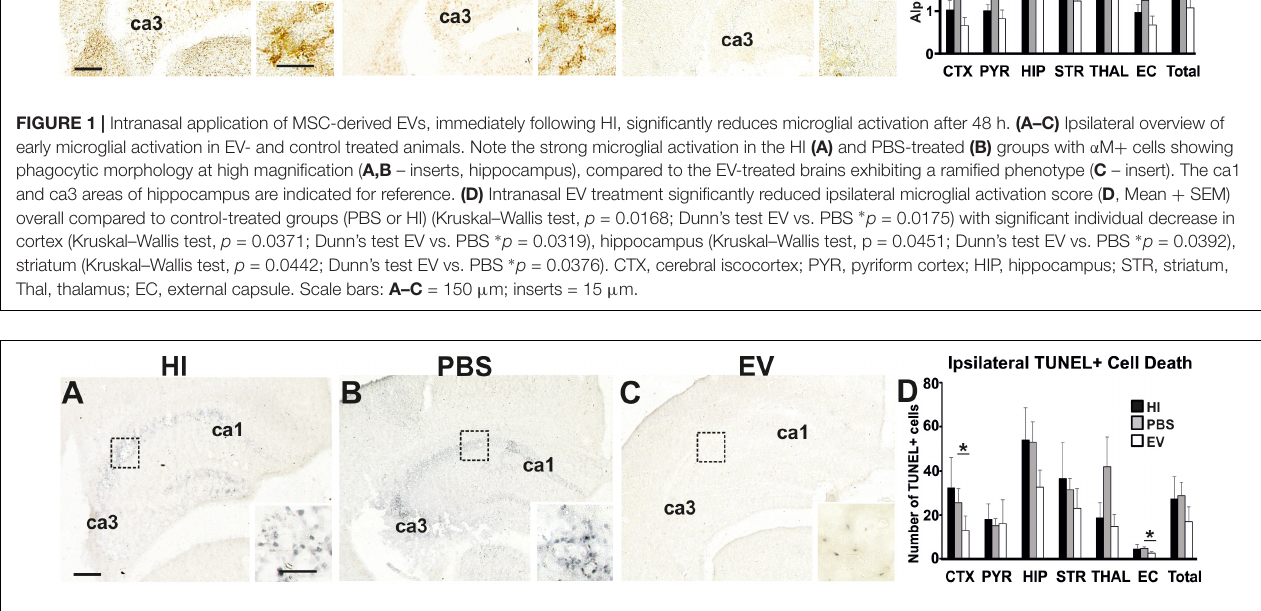
FIGURE 2 | Intranasal application of MSC-derived EVs, immediately following HI, significantly reduces TUNEL + cell death after 48 h. (A–C) Histochemical overview of TUNEL + cell death in the ipsilateral forebrain of HI (A) , PBS- (B) , and EV-treated (C) animals. Note the typical pyknotic nuclear morphology of the TUNEL + cells observed in the HI and PBS groups ( A,B – inserts, hippocampus) and the lack of such cells in the EV-treated group ( C – insert). The ca1 and ca3 areas of hippocampus are indicated for reference. (D) Quantification of the number of TUNEL + cells per 20 × eye-field (Mean + SEM). Compared to HI and PBS-treated control animals, Intranasal EV treatment significantly reduced ipsilateral TUNEL + cell death in cortex (Kruskal–Wallis test, p = 0.0305; Dunn’s test EV vs. PBS ∗ p = 0.0320) and external capsule (Kruskal–Wallis test, p = 0.0131; Dunn’s test EV vs. PBS ∗ p = 0.0117). CTX, cerebral iscocortex; PYR, pyriform cortex; HIP, hippocampus; STR, striatum; Thal, thalamus; EC, external capsule. Scale bars: A–C = 150 µ m; inserts = 15 µ